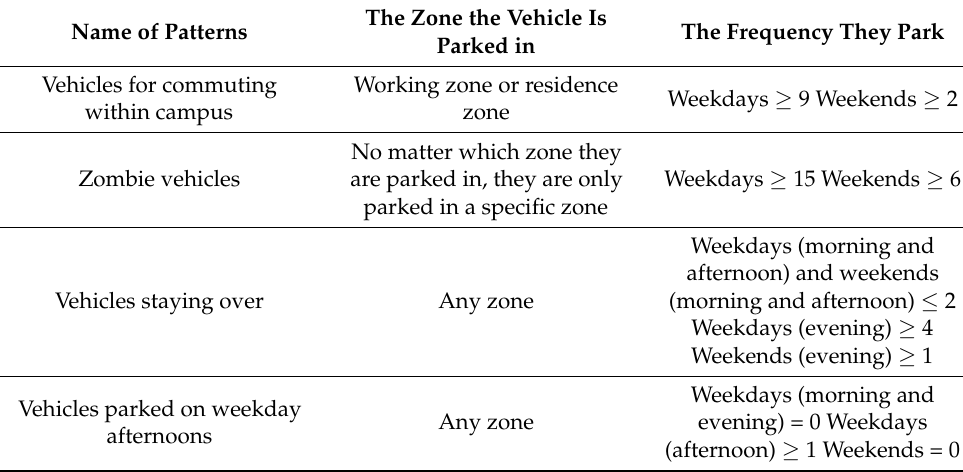
Table 2. Semantic pattern rules for parking